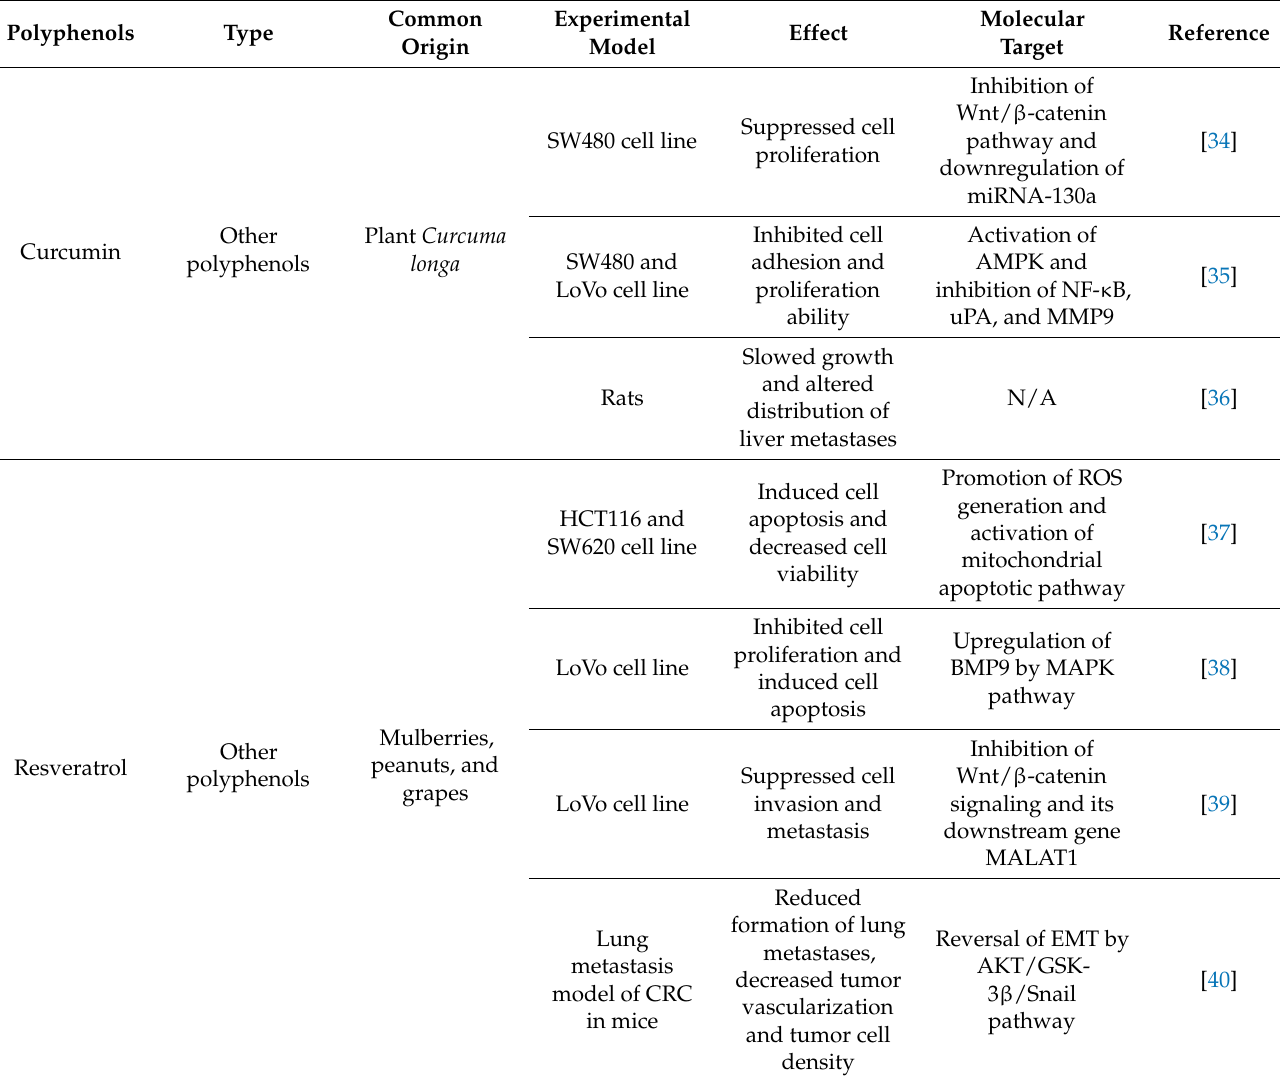
Table 1. The anti-CRC effects of different types of